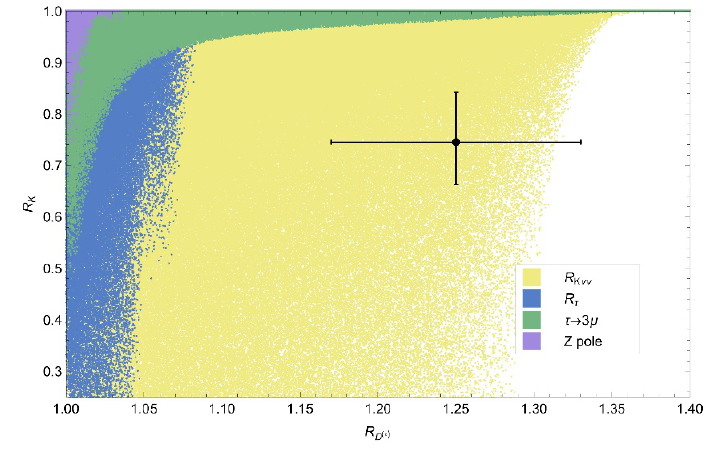
Figure 1 . Impact of one-loop-induced constraints on the values of R (cid:28)=‘ C 3 2 f(cid:0) 3 ; 3 g , (cid:21) e 2 f(cid:0) 0 : 3 ; 0 : 3 g and (cid:21) d 23